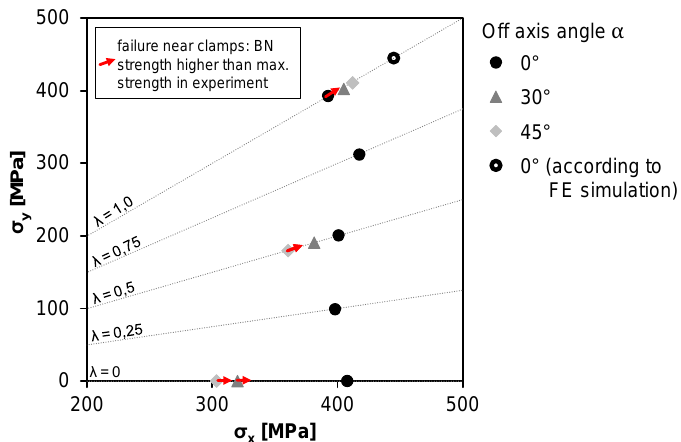
Figure 12. Maximum nominal stresses (BN strength) for all biaxial tensile tests of FML-2024-T3-3/2- 0.4.